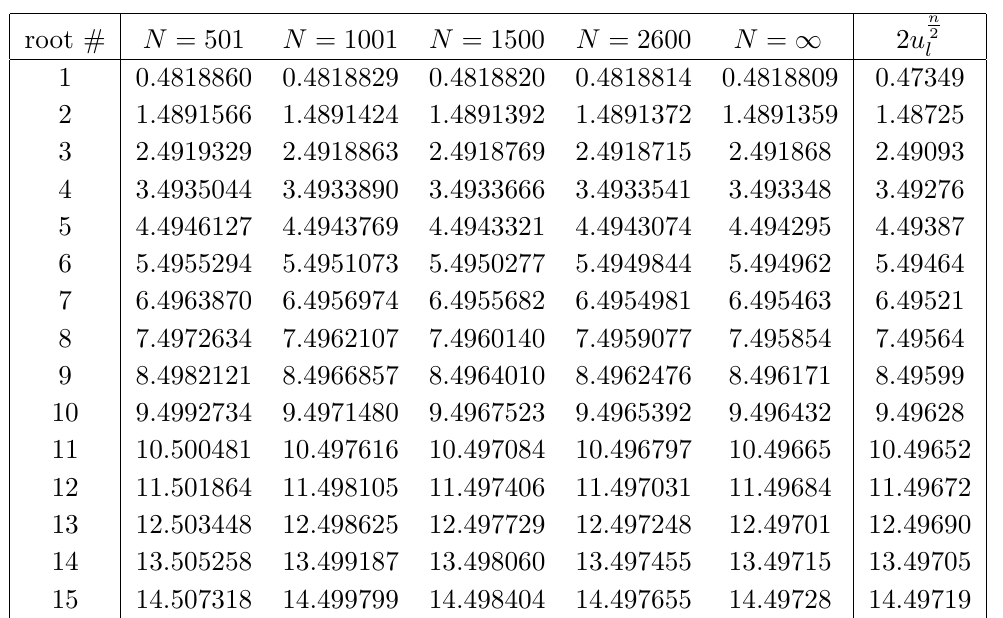
(cid:2) (cid:3) n (cid:22) ( N ) , where (cid:22) ( N ) > 0 are the roots of the vacuum eigenvalue l l (cid:25)